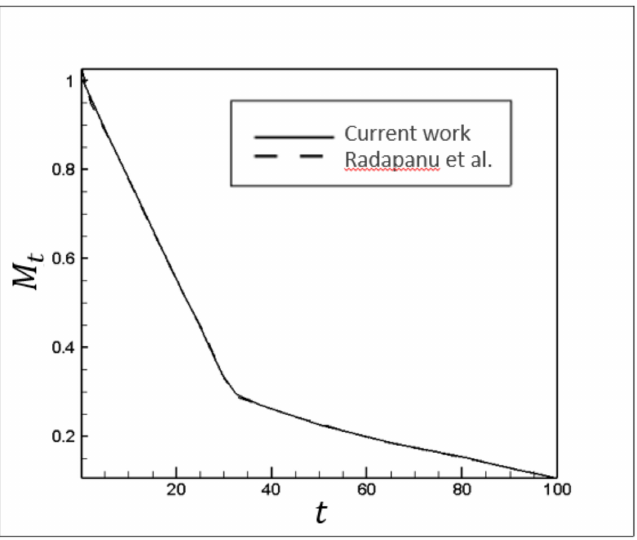
Figure 4. A comparison between the results of the present study and Redapangu et al.